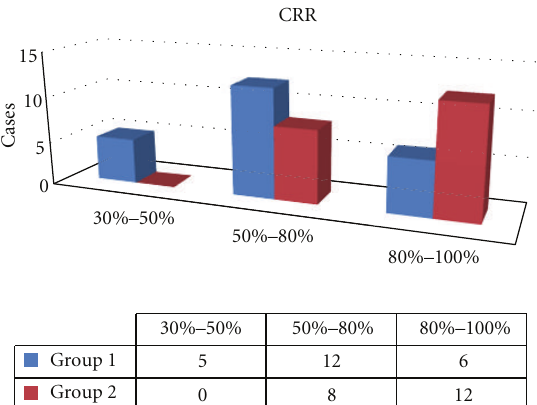
Figure 3: The CRR in the group with taste disorder and the group without taste disorder.